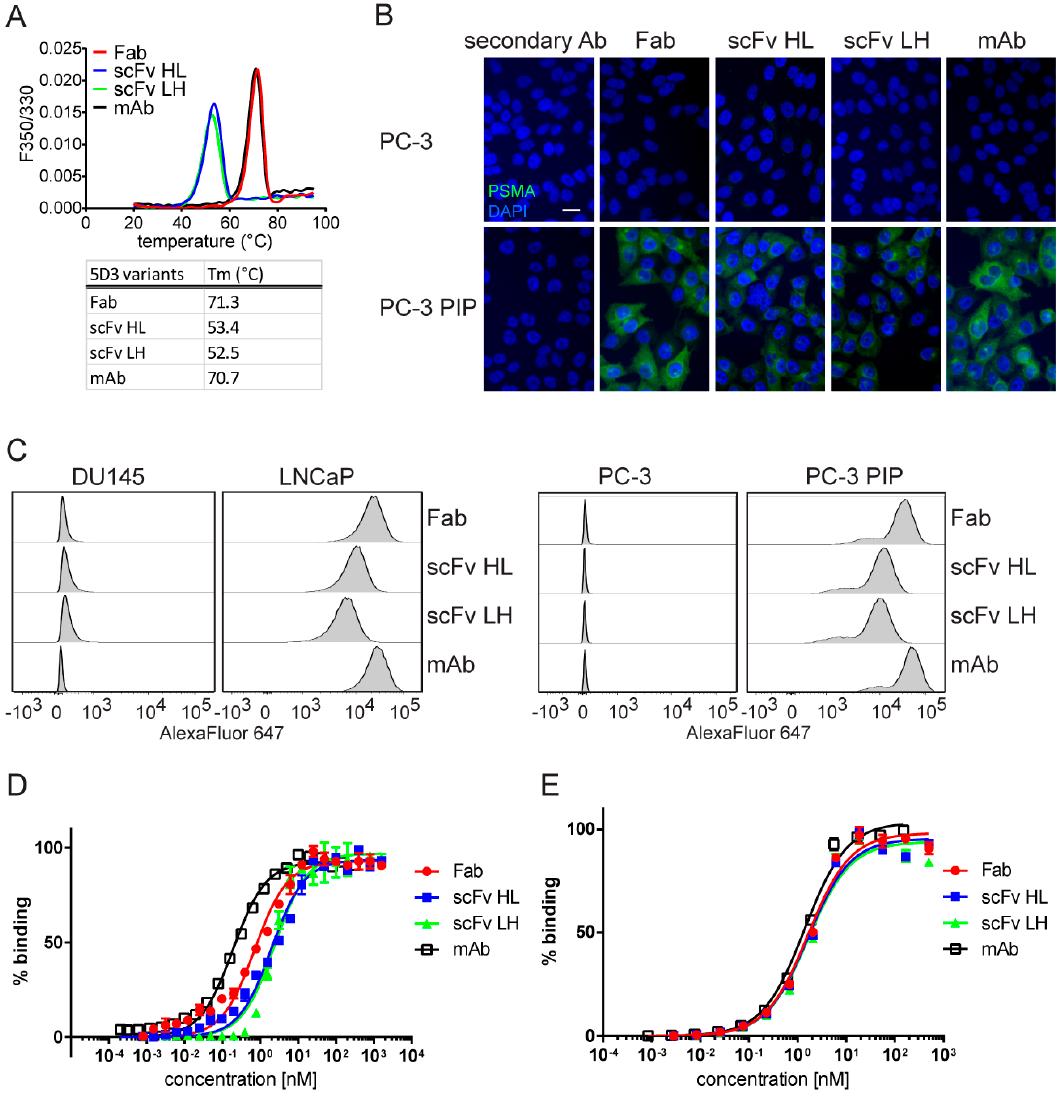
Figure 4. Functional characterization of S2-expressed 5D3 variants. ( A ) Thermal stability was determined using nanoDSF. Melting temperature curves and corresponding numerical values are shown. ( B ) Specificity of 5D3 variants evaluated by indirect immunofluorescence microscopy. PC-3 PIP (PSMA-positive) and parent PC-3 (PSMA-negative) cells were fixed by formaldehyde and permeabilized by Triton X-100 prior to incubation with recombinant 5D3 variants and secondary antibodies (green channel). Cell nuclei were counterstained with DAPI (blue channel). The scale bar represents 25 µm. ( C ) Flow cytometry analysis of PSMA-positive (PC-3 PIP, LNCaP) and negative (PC-3, DU145) cells stained by 100 nM purified 5D3 variants. Each gated population represents approximately 30,000 viable cells. ( D , E ) Determination of binding affinity of 5D3 variants by native ELISA ( D ) and flow cytometry ( E ) using purified PSMA and live LNCaP cells, respectively. PBS and DU145 cells were used as negative controls for ELISA and flow cytometry samples, respectively, and corresponding background signals were subtracted.